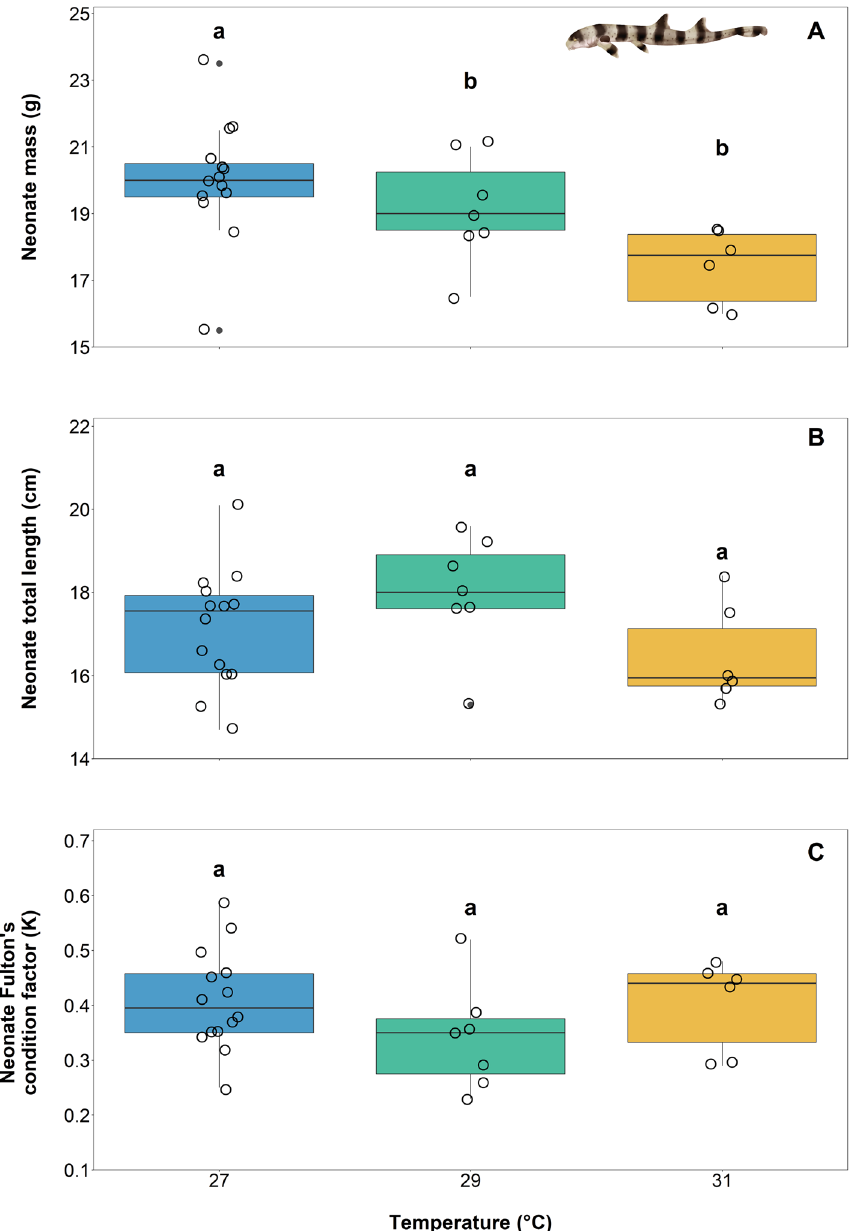
Figure 3. Mean (± SE) mass (g) ( A ), total length (cm) ( B ), and Fulton’s condition factor (K) ( C ) at hatching across three temperature treatments of 27, 29, and 31 °C. Boxes and whiskers represent the median, 25th, and 75th quartiles and 10 and 90th percentiles, respectively. The filled circles represent outliers, and open circles represent observations. Differing lowercase letters denote statistically significant differences at α = 0.05 (see